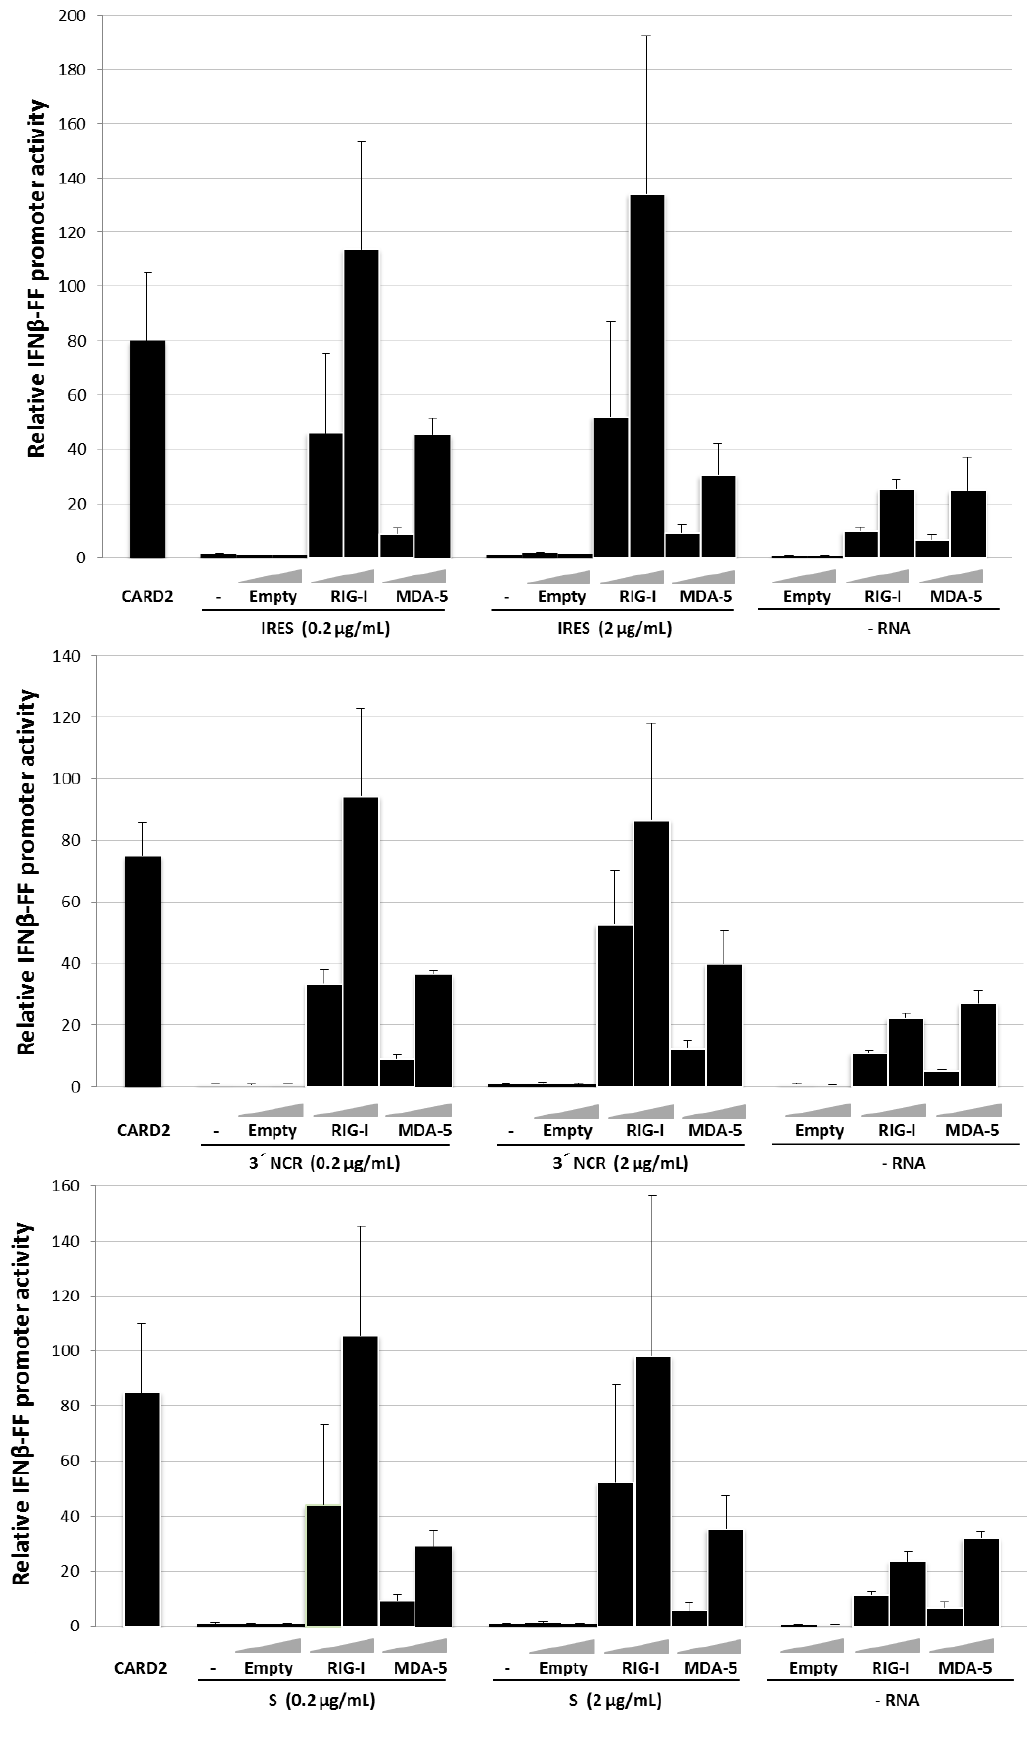
Figure 1. Figure 1. Cont.